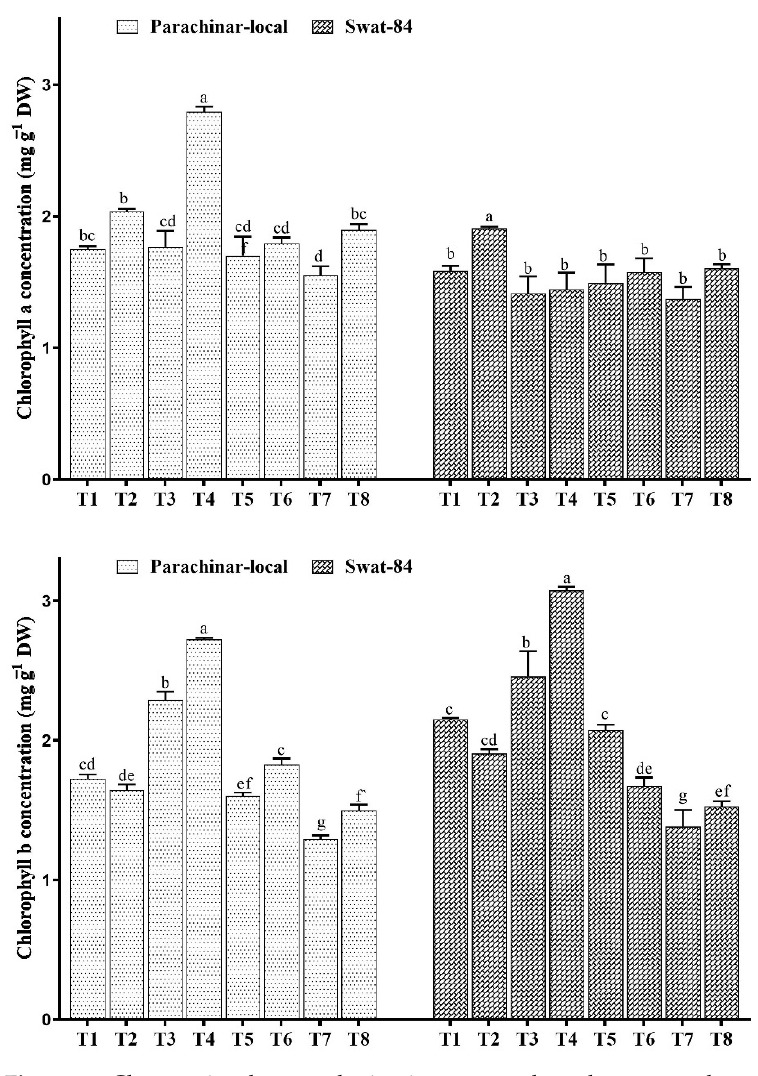
Figure 1. Changes in photosynthetic pigments under salt stress and exogenous JA application. Different letters for each column for each variety show significantly different values at p < 0.05 according to Duncan’s method. T1 (Control), T2 (Control + JA), T3 (40 mM), T4 (40 mM + JA), T5 (80 mM), T6 (80 mM + JA), T7 (120 mM), T8 (120 mM +